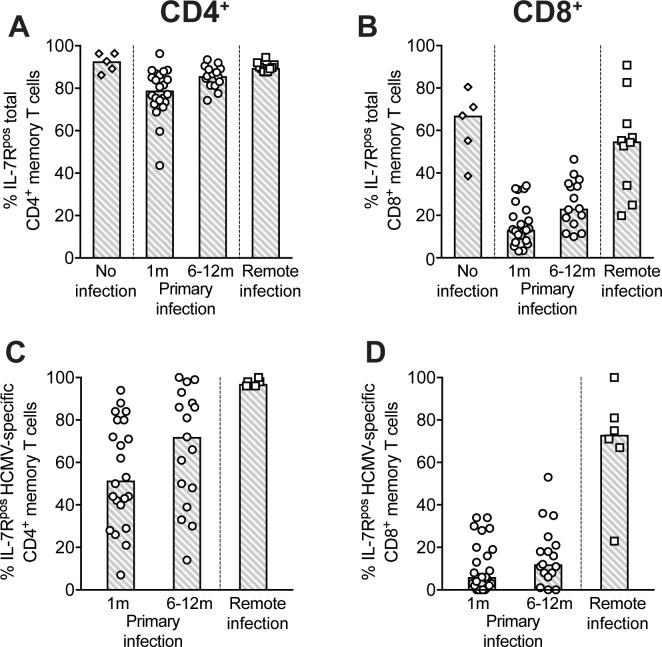
IL-7Rneg short-term effector vs IL-7Rpos long-term memory T cells persistance at late time points after primary HCMV infection.Frequencies of IL-7Rpos T cells in (A-B) total memory and (C-D) HCMV-specific CD4+ or CD8+ T cells are reported. Data are from HCMV-seronegative subjects (“No infection”, n = 5, only for total memory), patients (both pregnant and non-pregnant) within 1 month (n = 25) or at 6–12 months (n = 18) after primary infection onset, and subjects with remote infection (n = 10). “HCMV-specific” indicates the sum of the single protein-specific T cells. Each symbol represents an individual and column upper limits indicate median values.